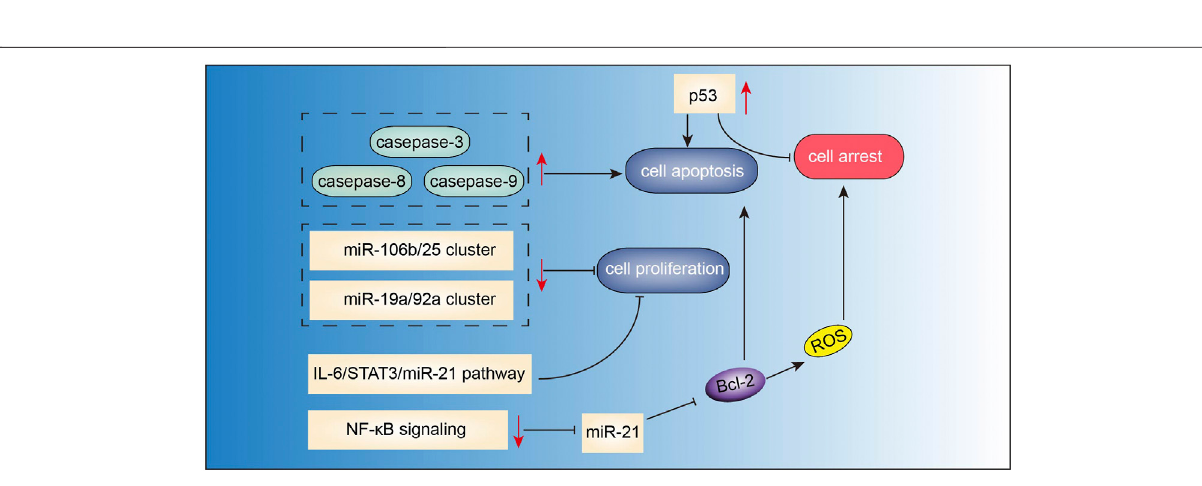
FIGURE 6 | Action pathways involved in the anti-MM effects of berberine. represents inhibitory effects, represents stimulative